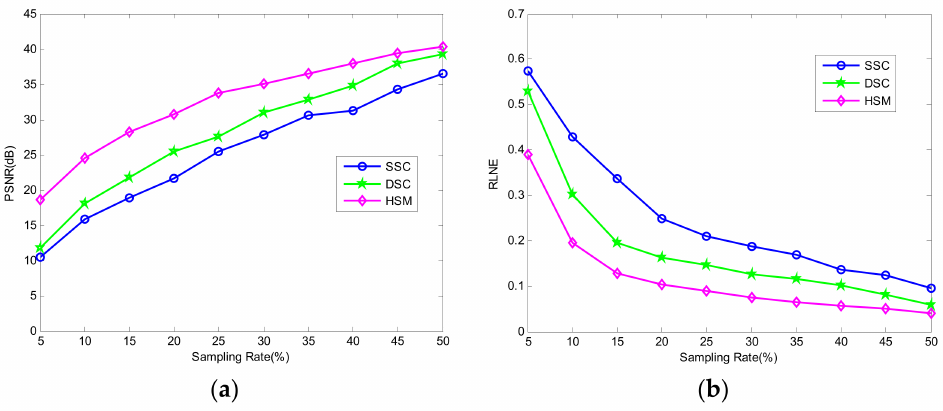
Figure 5. Comparison of the PSNR and RLNE curves to different sampling rates. ( a ) PSNR; ( b )